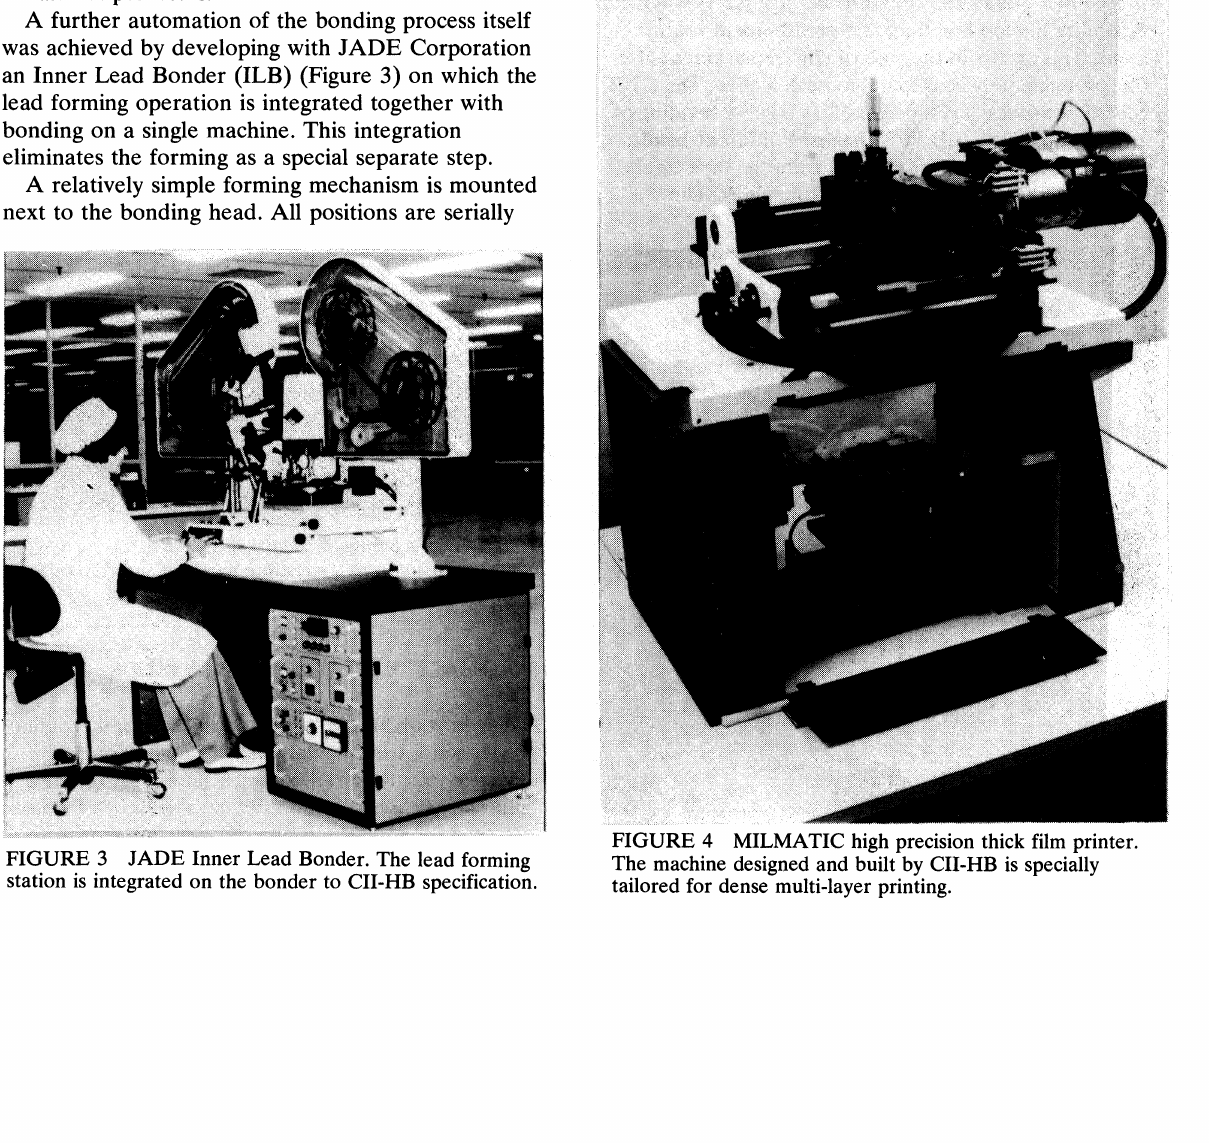
FIGURE 3 JADE Inner Lead Bonder. The lead forming station is integrated on the bonder to CII-HB specification.